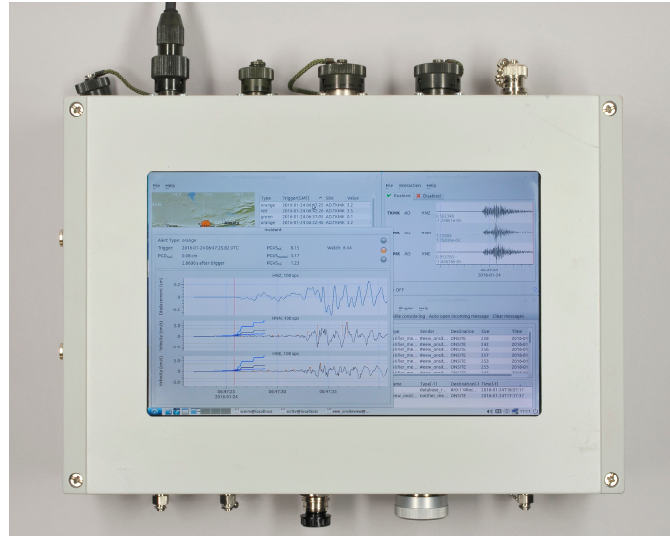
Figure 1. A MPwise unit. This version includes a touchscreen embedded in the housing. While this arrangement is not standard, an external touchscreen can be connected to all units. In this image, the touchscreen display shows the operation of the onsite EEW software described in [5–7]. The dimensions of the latest version are: length 20.5 cm, width 16 cm, and height 8 cm.